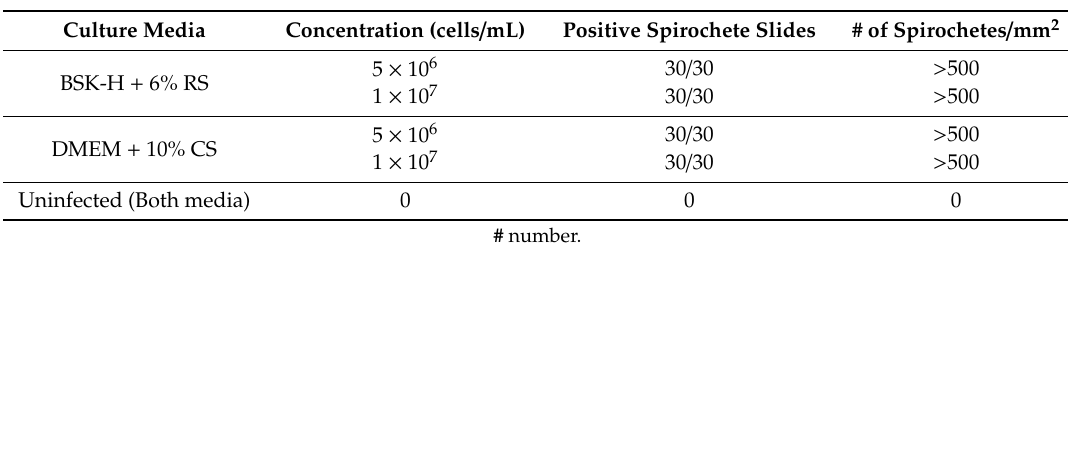
Table 1. Quantitative summary of spirochetes found in B. burgdorferi -inoculated murine skin